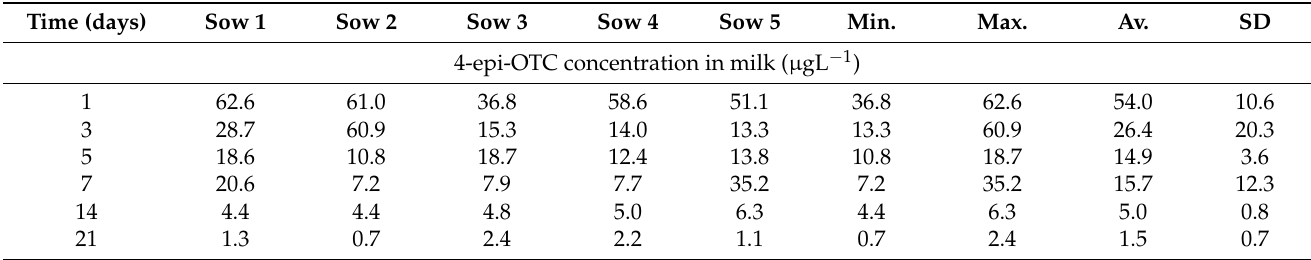
Table 3. Concentrations of 4-epi-oxytetracycline (4-epi-OTC) in sow milk after a single